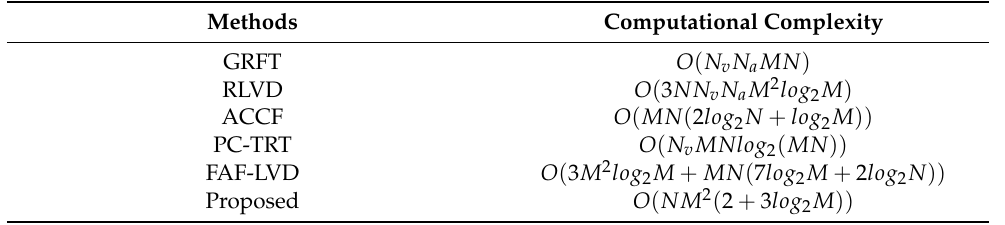
Table 1. Computational complexity comparison.